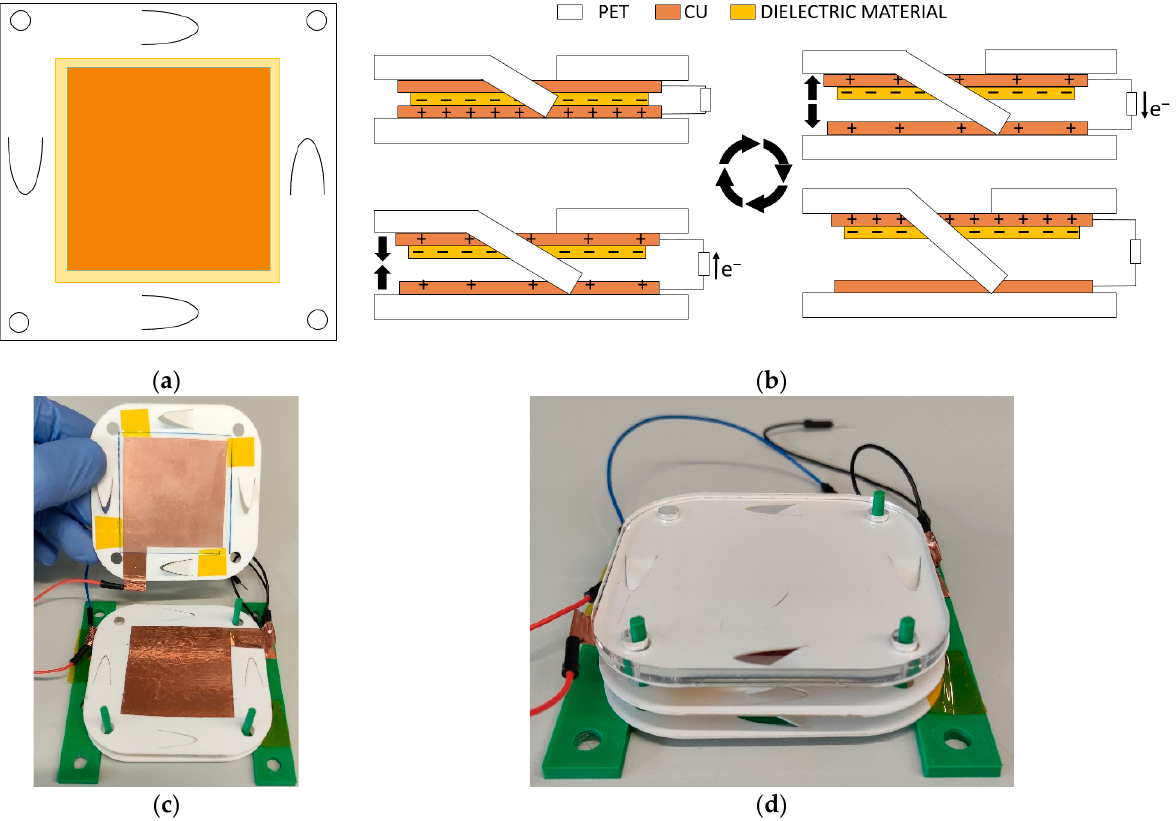
Figure 8. ( a ) Scheme of the TENG device; ( b ) scheme of operation of the TENG device; ( c , d ) image of the manufactured TENG device before and after assembling, respectively. the manufactured TENG device before and after assembling,